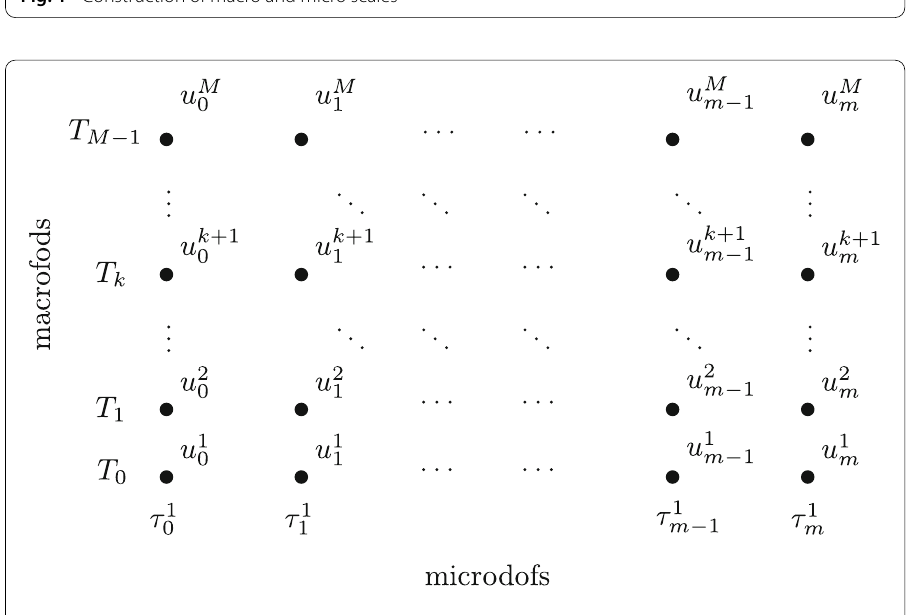
Fig. 1 Construction of macro and micro scales